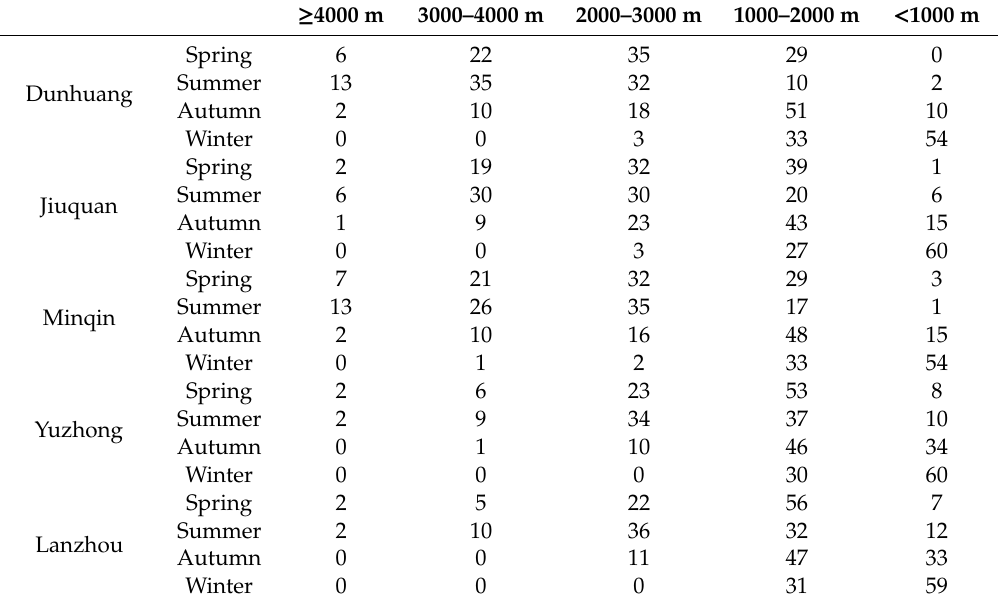
Table 2. The frequency of the boundary layer height in di ff erent grades at 14:00 BJT